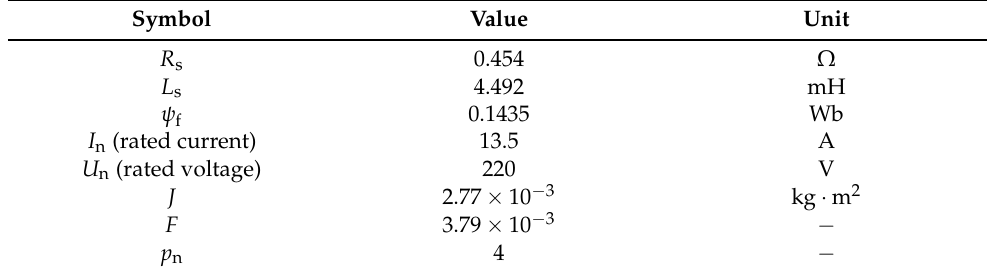
Table 1. Specification parameters of a